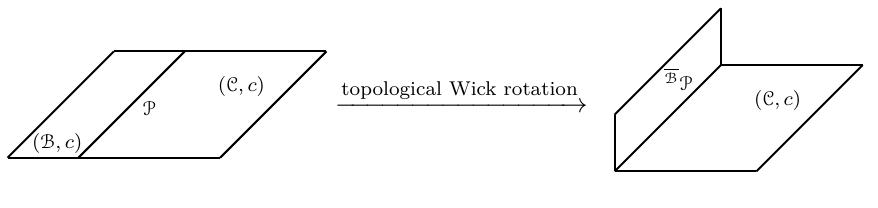
Figure 2 . The idea of topological Wick